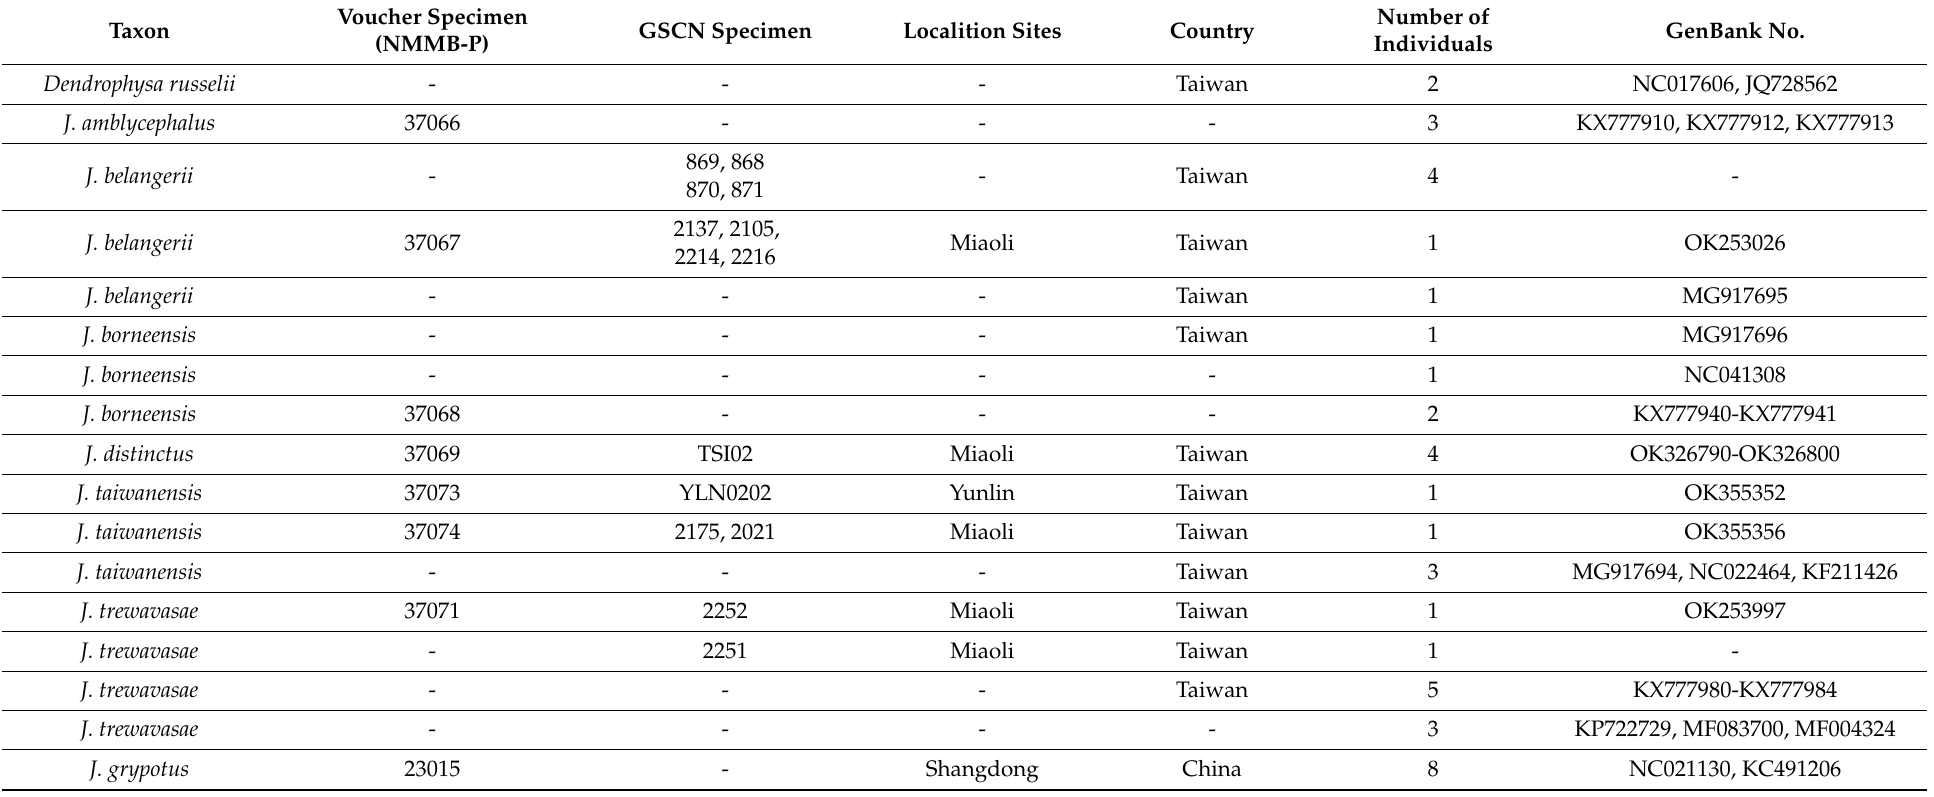
Table 2. Taxa, vouchers, locality, and GenBank accession numbers of specimens of locally known Johnius species and Dendrophysa russelii used in the DNA COI barcoding